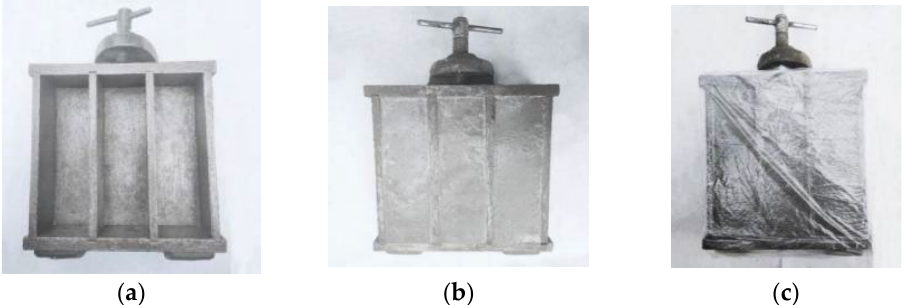
Figure 1. Photographs of specimens formed by steel molds ( a ) Steel mold, ( b ) hot-dry curing and ( c ) Film curing.